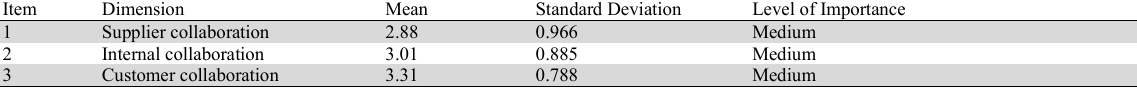
Descriptive statistics for Supply Chain Collaboration